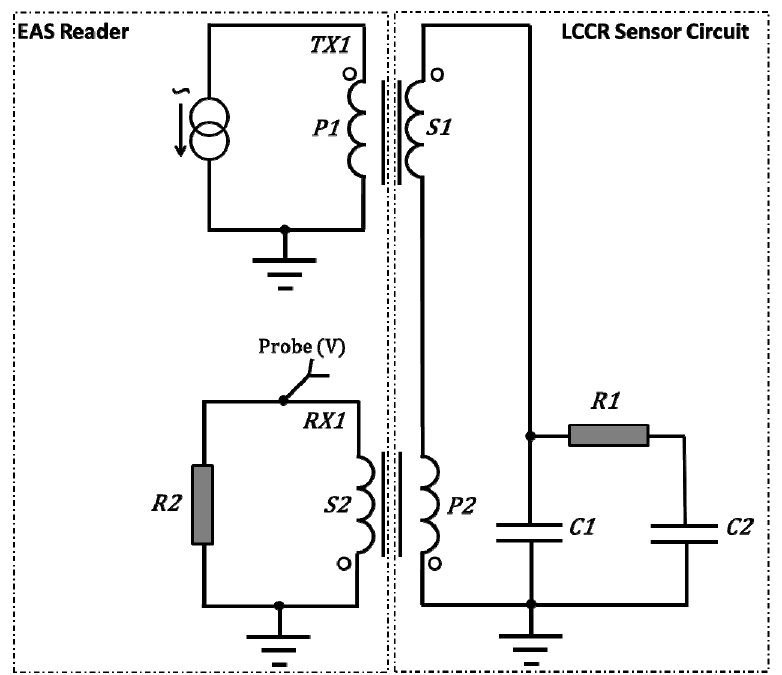
Figure 2. Electrical layout used for the simulation of the Electronic Article Surveillance (EAS) tag reader and EAS